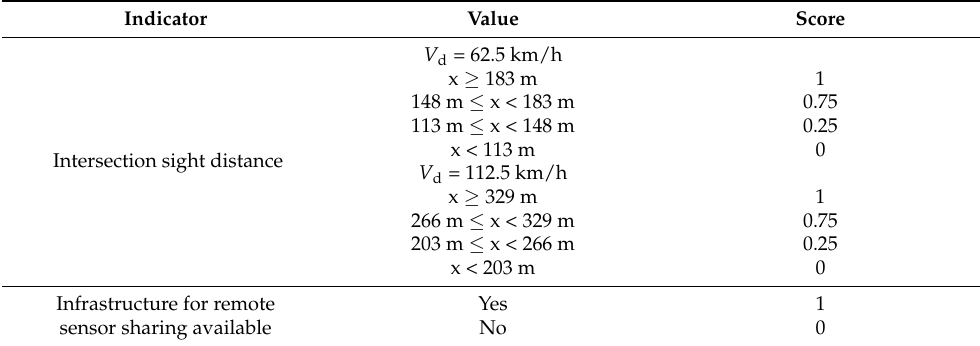
Table 3. The assessment framework—object detection distance